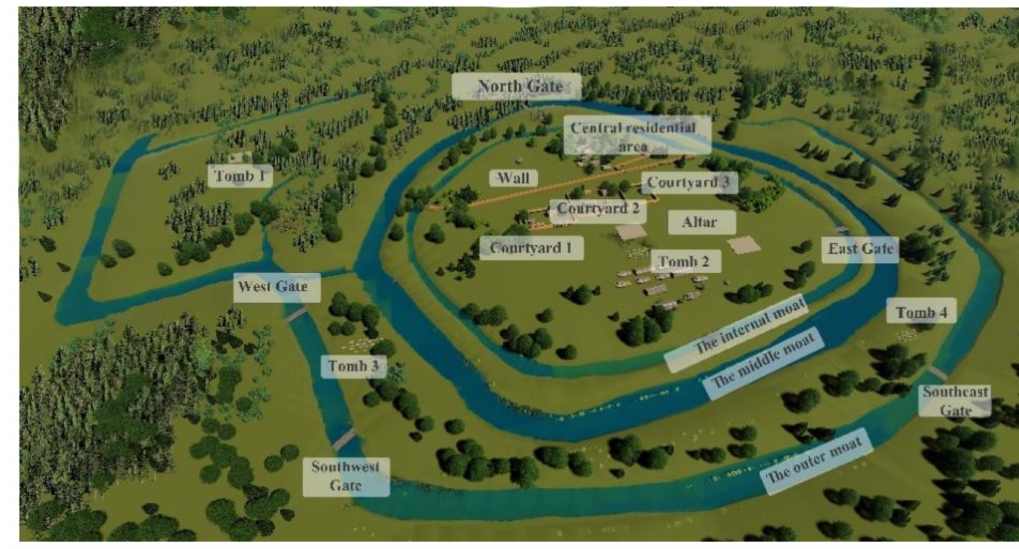
Figure 17. Early settlement landscape of the SHS site.